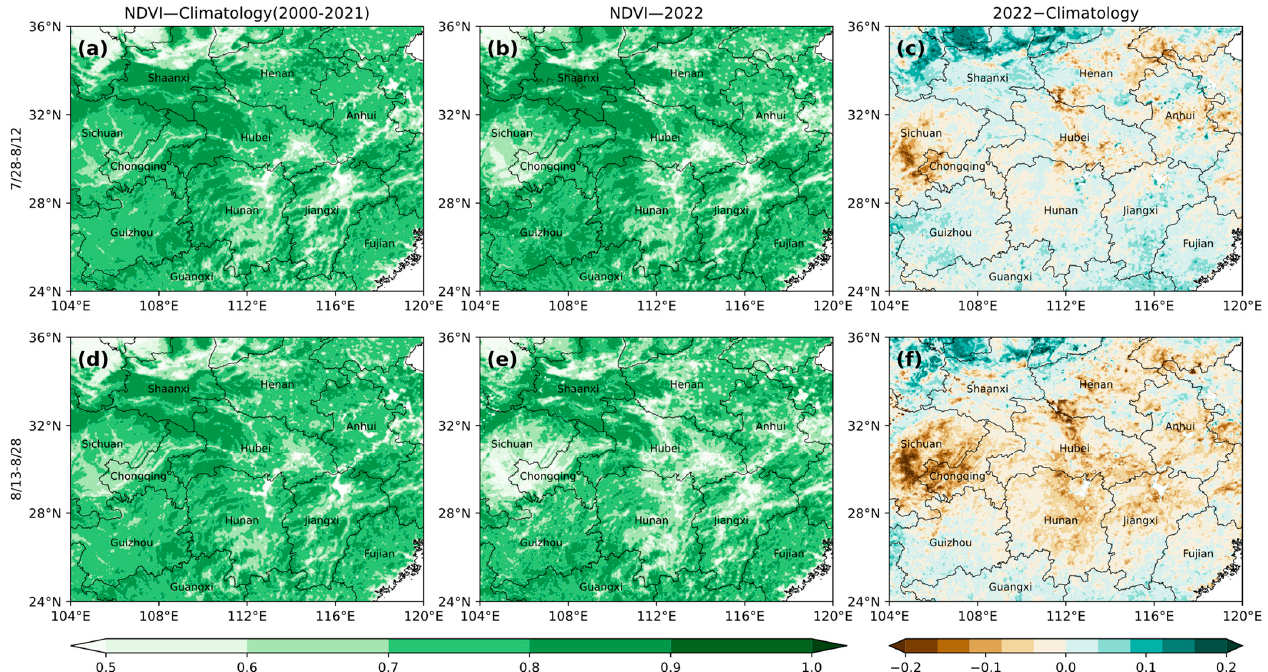
Figure 2. Climatology (2000–2021) NDVI in early ( a ) and late ( d ) August, NDVI in 2022 in early ( b ) and late ( e ) August and the differences between them (( c ) for early August and ( f ) for late August).